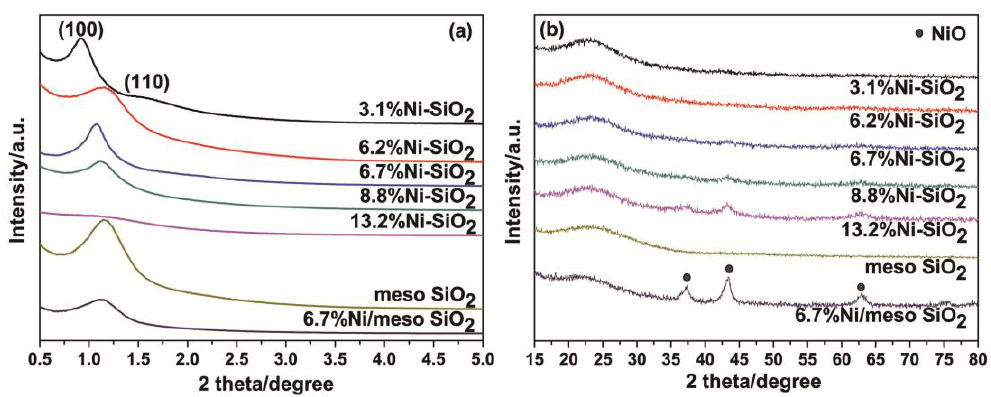
Figure 1. Small-angle ( a ) and wide-angle ( b ) XRD patterns of the meso-SiO SiO and Ni-SiO 2 2